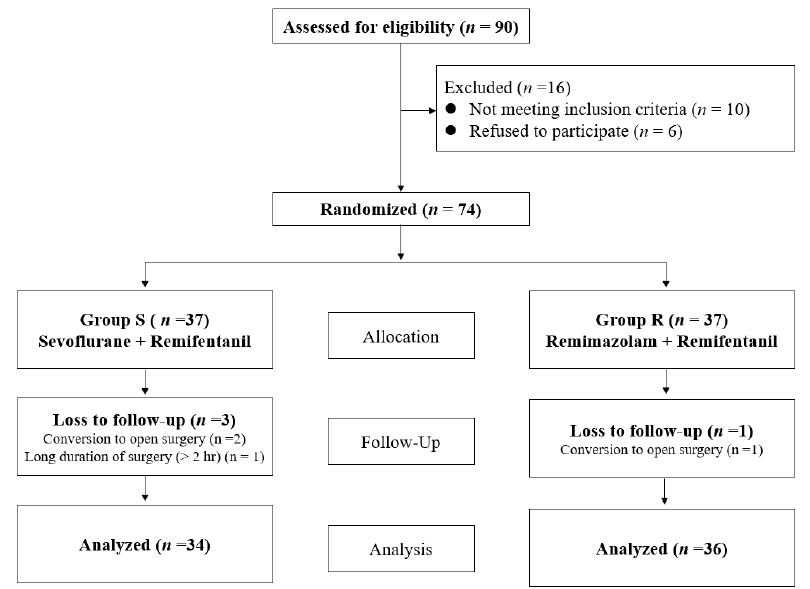
Figure 1. CONSORT flow diagram.